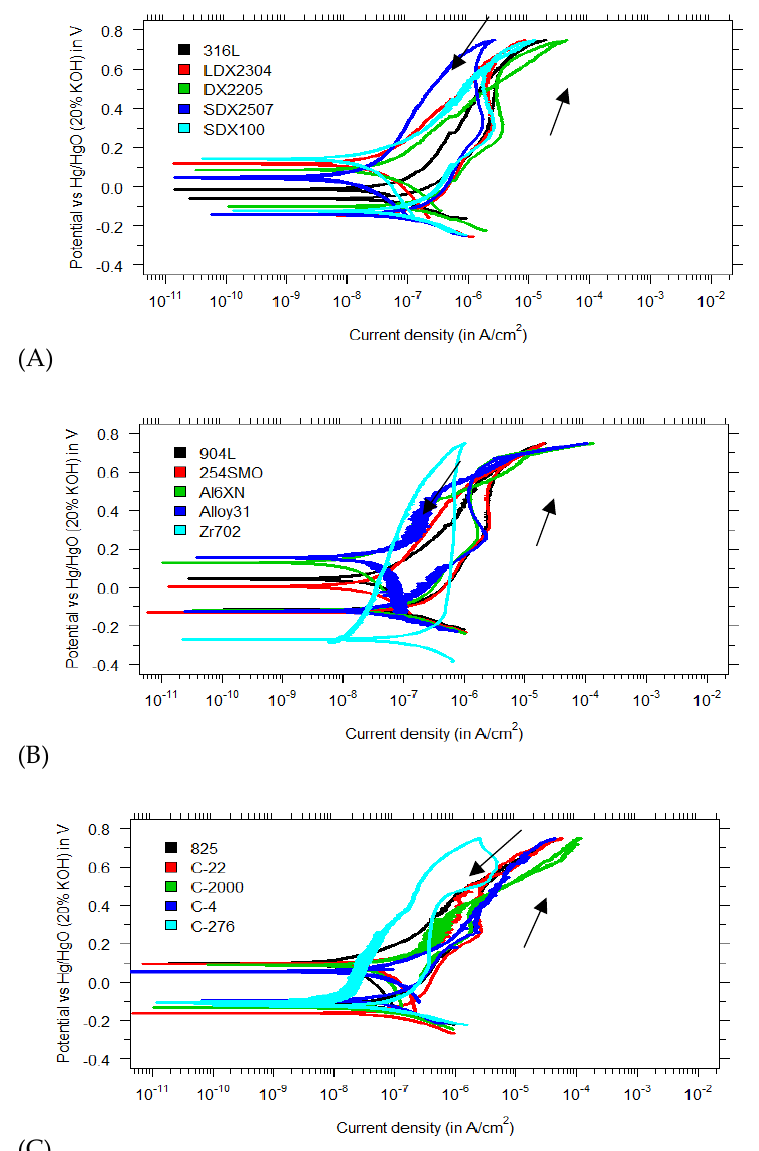
Figure 3. Polarization curves in saturated Ca(OH) 2 (pH 12.5) with 1 M Cl − for ( A ) regular, duplex and super duplex stainless steels; ( B ) superaustenitics and zirconium-based alloys; and ( C ) nickel − based alloys.